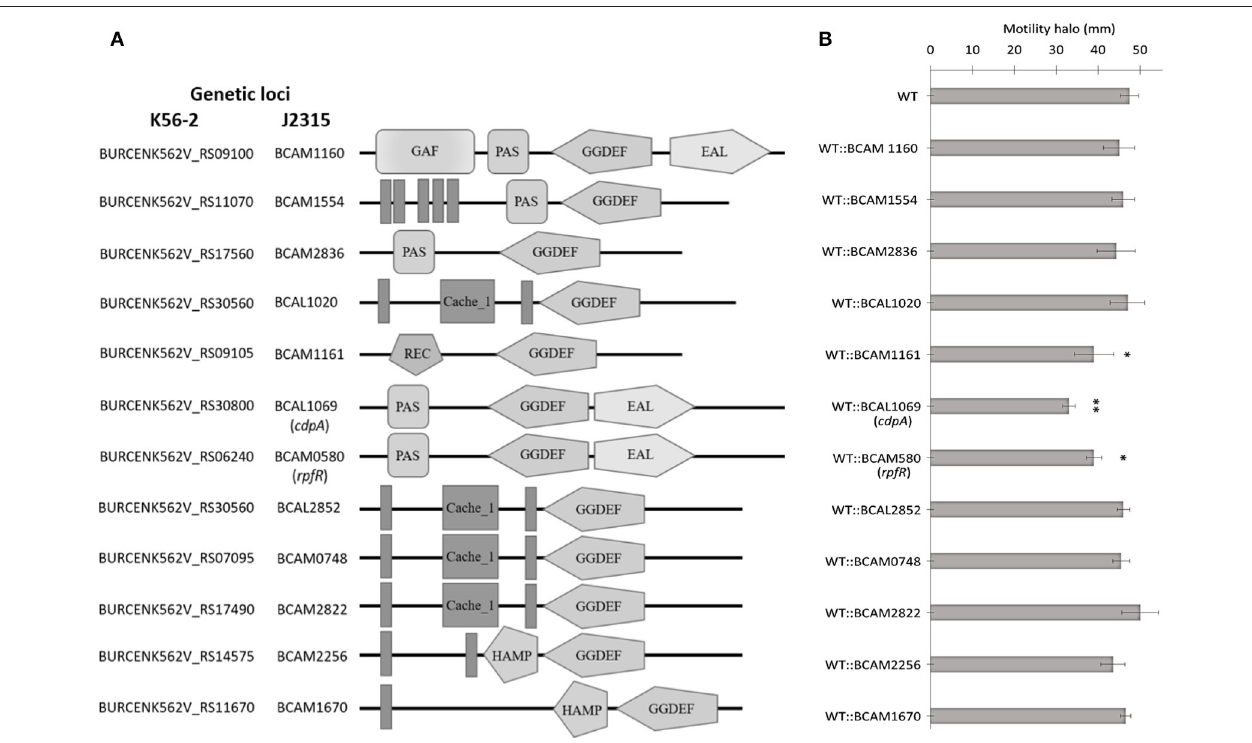
FIGURE 2 | Predicted domains coded by c-di-GMP metabolic proteins and their role in swimming motility of B. cenocepacia K56-2 WT. (A) Putative proteins with c-di-GMP modulating and signal transduction domains as predicted by SMART. Amino acid sequences were obtained from the genome of B. cenocepacia J2315. EAL, putative diguanylate phosphodiesterase; GG(D/E)EF, putative diguanylate cyclase; PAS, P er/ A RNT/ S im; GAF, c G MP-specific phosphodiesterase/ A denyly cyclase/ F hlA; REC, cheY-homologous receiver domain; Cache, CA lcium channels and CHE motaxis receptors; HAMP, H istidine kinases/ A denylate cyclases/ M ethyl accepting proteins/ P hosphatases; Vertical bars, transmembrane domain. Domains are not drawn to scale. (B) The swimming motility of the mutants was examined in semi-solid SCFM 0.3% agar plates after 24h at 37 ◦ C. Three independent experiments were performed in duplicates (* p < 0.01; ** p < 0.001).